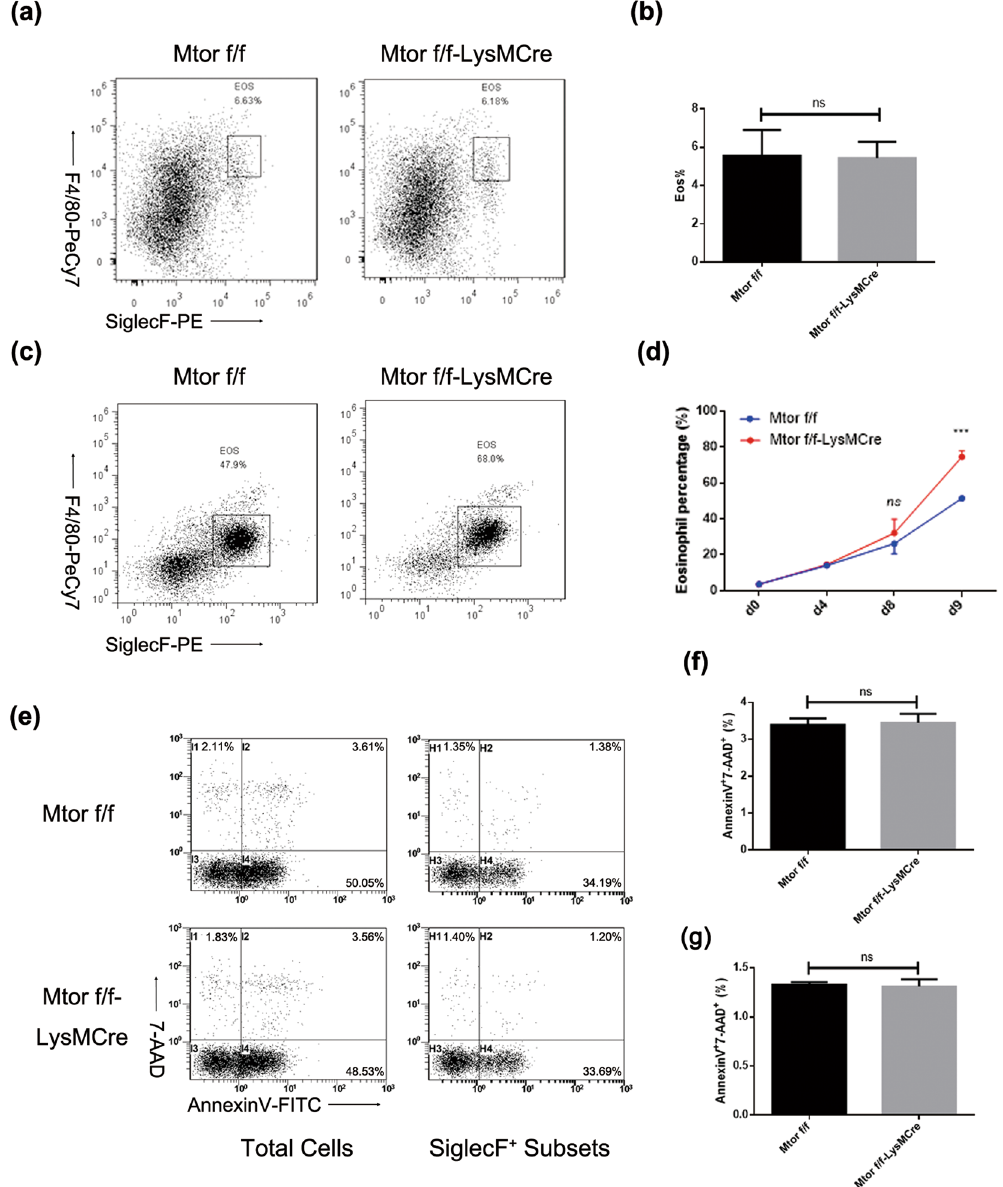
Figure 3. Myeloid specific knockout of mTOR results in elevated levels of eosinophil development without altering apoptotic levels. ( a and b ) Bone marrow cells were harvested and stained with PE-conjugated SiglecF and Pe-Cy7-conjugated F4/80 post lysing of red blood cells. Representative dot plots are shown (a) and statistical analysis (b) was conducted as means ± SEM using Student’s T-test. ( c , d ) Liquid culture of BMDE with two strains of mice. Representative dot plots are displayed (c) and statistically analysed on day 8 and 9 (d). ( e – g ) On day 9, cells were harvested and stained with SiglecF-PE, then stained with AnnexinV-FITC and 7-AAD before flow cytometric analysis. Representative dot plots are shown (e), and analysis of the percentage of apoptotic cells (regarded as AnnexinV + 7-AAD + ) were calculated in total cells (f) and eosinophils (SiglecF + subsets, g) All the results above were repeated by three independent experiments. n.s. not significant, * P < 0.05, ** P < 0.01, *** P <